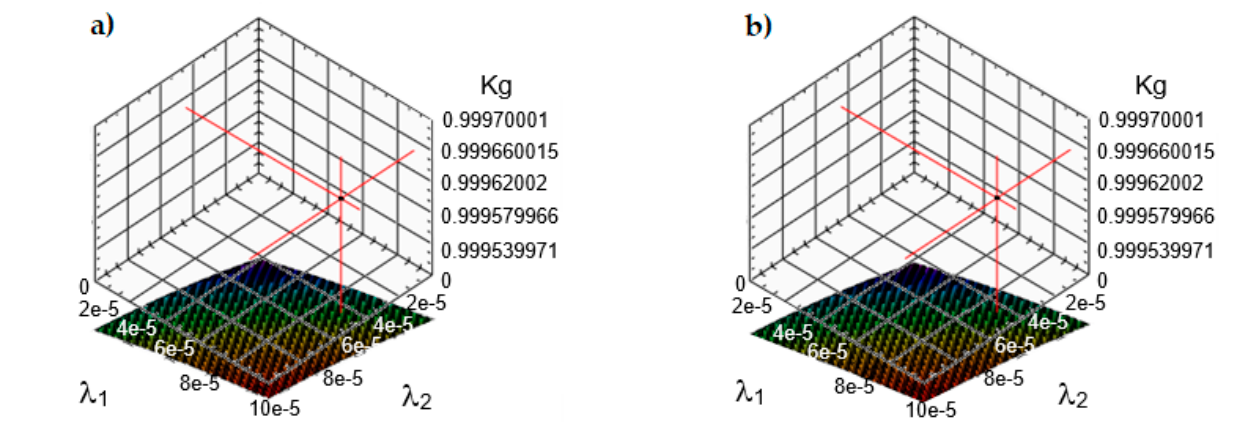
Figure 9. Graphs of the test of the mean time between successive failures, for constant parameters, including: mean repair time 0.7 [h]; mean operating time I type 0.8 [h]; type II mean service time =